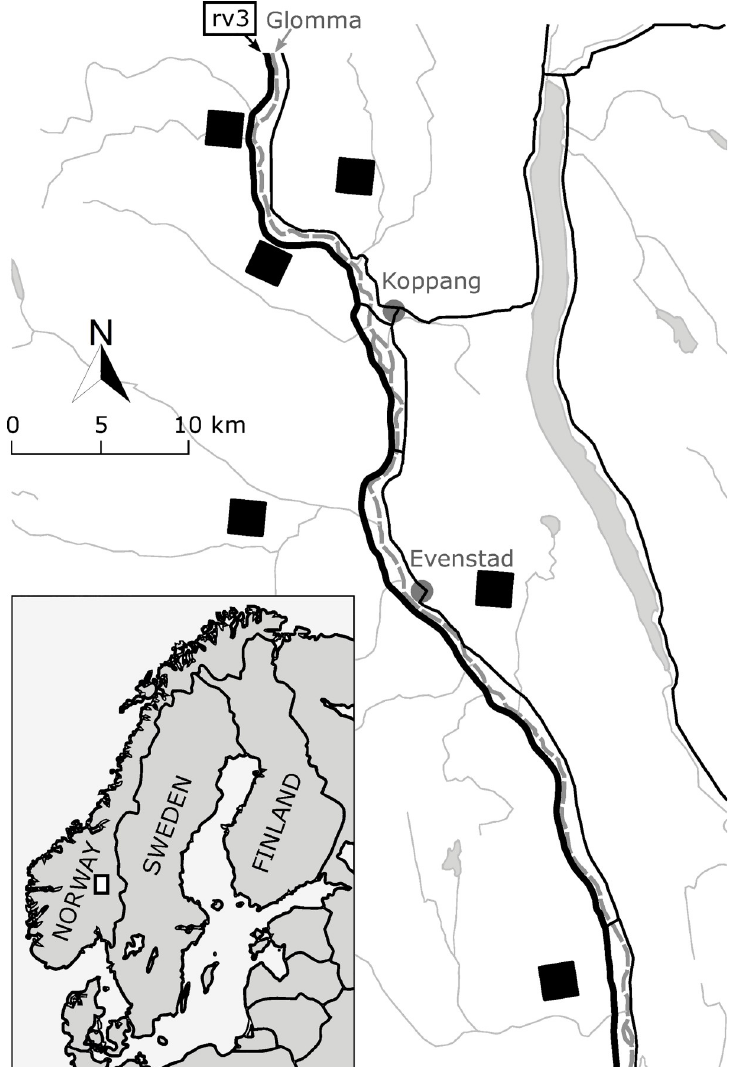
Fig 2. Map of the study area (inset: White square) in southeastern Norway. Thick black line: main road 3 (rv3); dashed grey line: the Glomma River; black squares: sampling blocks, see text.